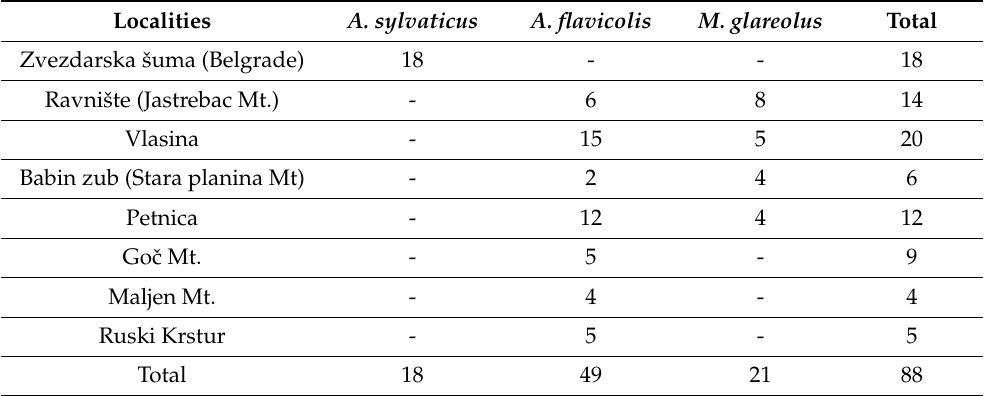
Table 1. The number of collected rodents across host species and localities. Localities A.